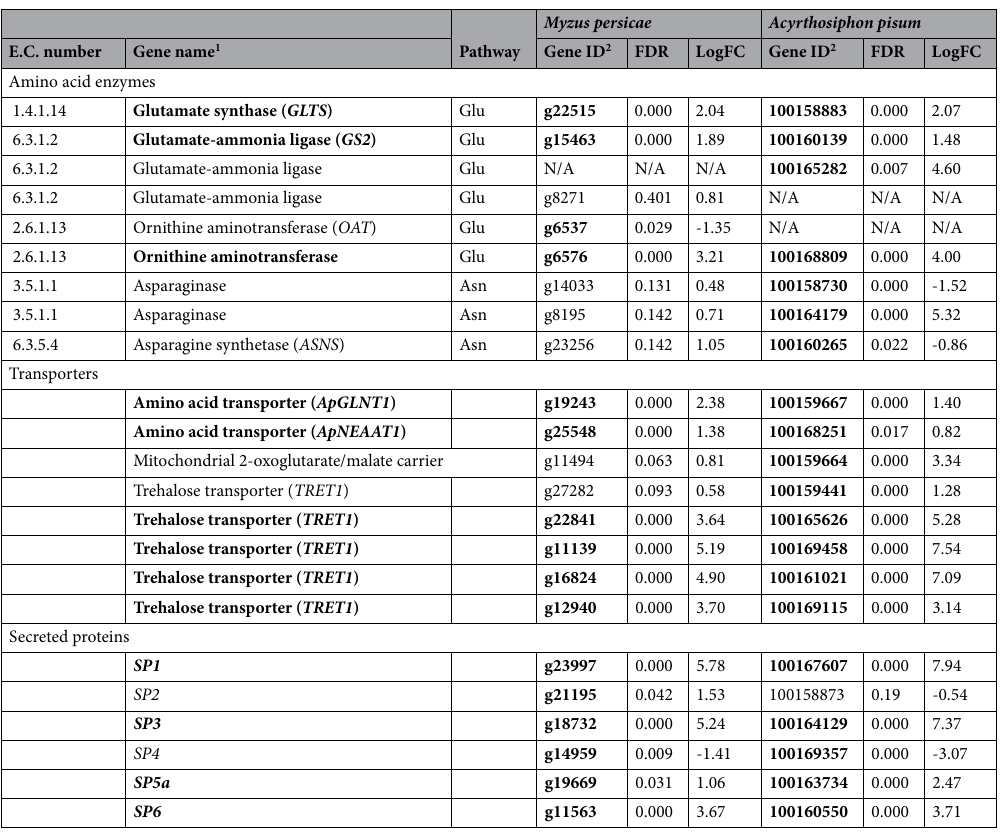
Table 2. Expression of symbiosis-related aphid orthologs in bacteriocytes compared to body tissues in two different aphid species. Each row contains a shared ortholog between M. persicae and A. pisum except for N/A which indicates no ortholog was identified between species. 1 Bolded Gene names indicate orthologs in both aphid species are significantly differentially expressed between bacteriocytes compared to body tissues where both FDR p-value ≤ 0.05 and fold change (FC) ≥ 1.5 (i.e. LogFC ≥ 0.5849). 2 Bolded Gene IDs indicate that the aphid gene is significantly differentially expressed between bacteriocytes compared to body tissues in that aphid species. nd= not detected.